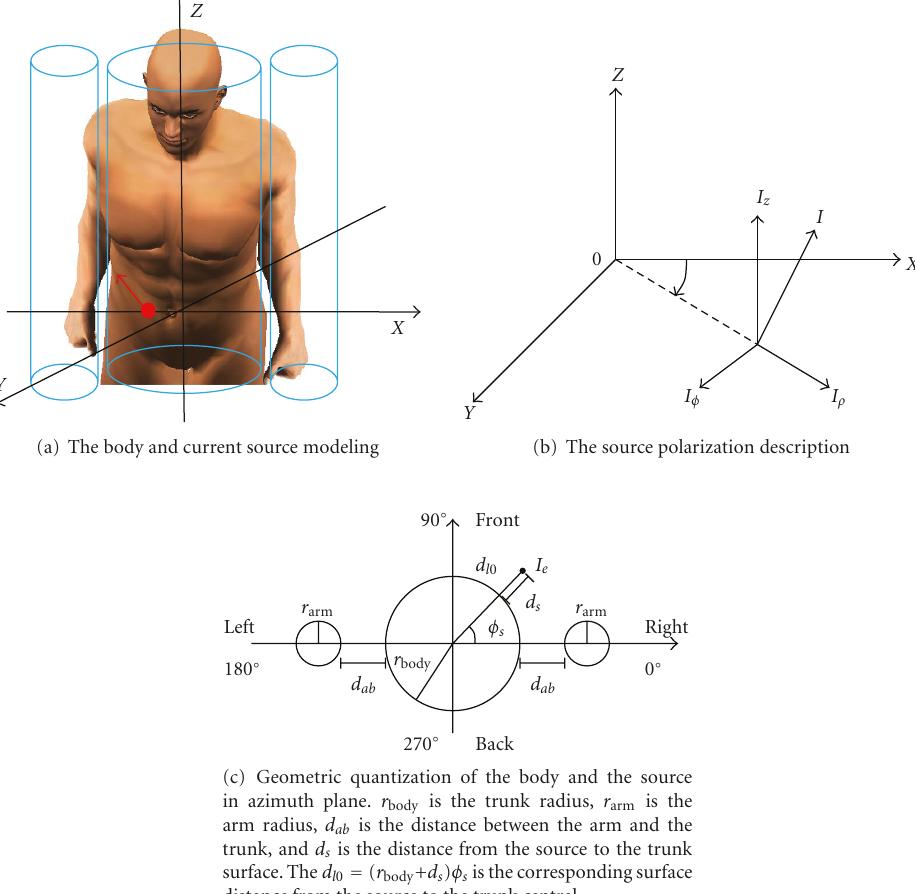
Figure 2: The human body and transmitter modeling by three lossy cylinders and one polarized point